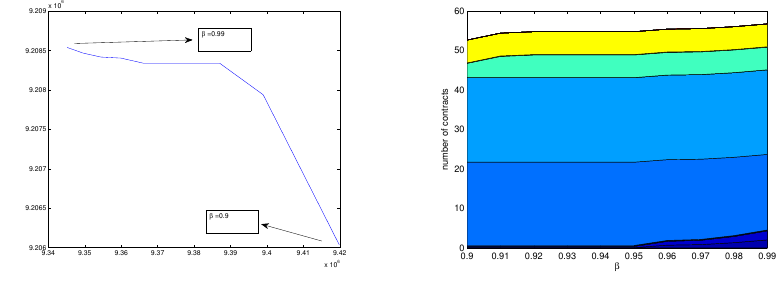
Figure 9. Effect of β for CVar